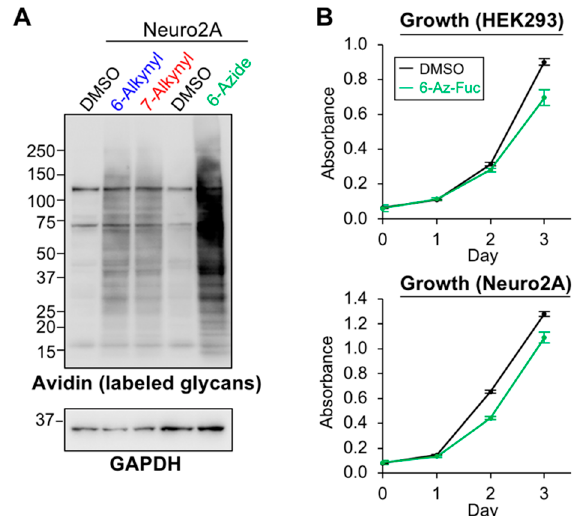
Figure 4. Labeling efficiency and cytotoxicity of 6-Az-Fuc. ( A ) Neuro2A cells were treated with DMSO, 100 μ M peracetylated 6-Alk-Fuc, 7-Alk-Fuc or 6-Az-Fuc. Incorporated Fuc analogs in the cell lysates were biotinylated by click chemistry, and the labeled glycans on proteins were detected by blotting with HRP-streptavidin. For labeling, the same concentrations of biotin-azide (lane 1–3) and biotin-alkyne (lane 4 and 5) were used. ( B ) Growth of HEK293 and Neuro2A cells was examined after addition of DMSO or peracetylated 6-Az-Fuc at Day 0 ( n = 3). All graphs show means ± SD.